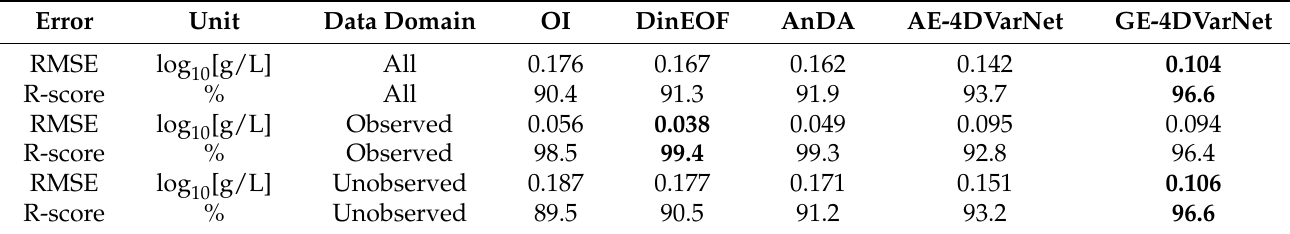
Table 1. RMSE and R-score computed for all methods over the SSSC validation period: these scores are computed globally (All) and over the observed data (Observed) and the missing data (Unobserved) patterns.